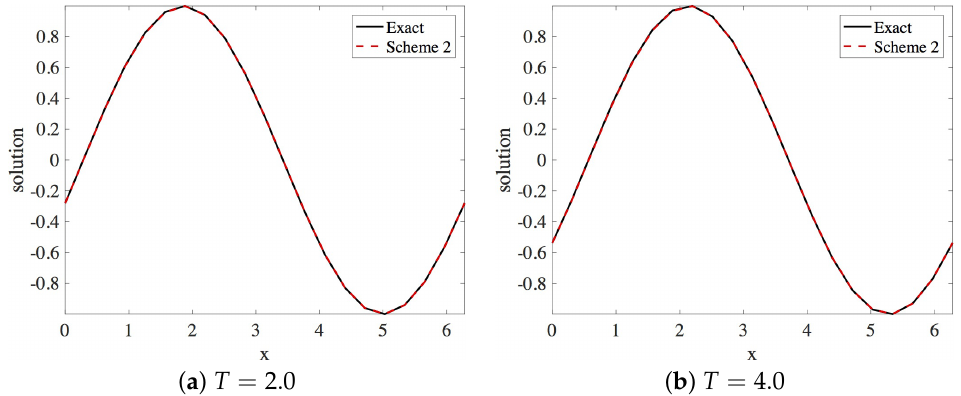
Figure 23. Plot of exact and numerical profiles (using Scheme 2) vs. x at times 2.0 and 4.0 using h = π /10 and k = 0.001 (Numerical Experiment 2).